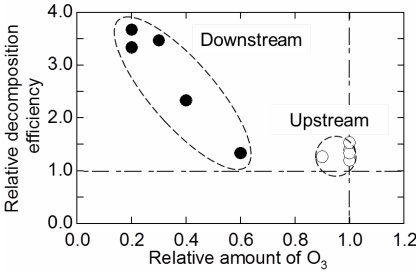
Figure 2. Relationship between the relative decomposition efficiency and relative amount of ozone.